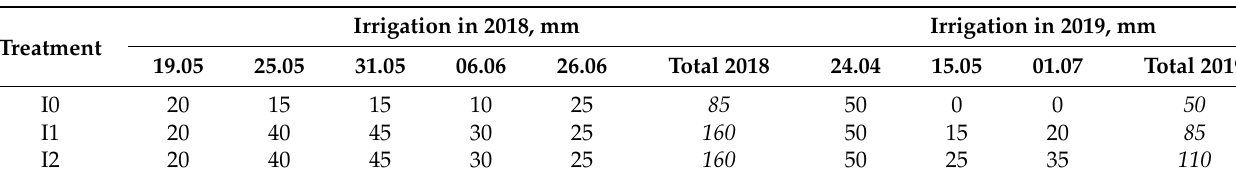
Table A2. Total irrigation amounts for different treatments. I0 corresponds to minimum irrigation, I1 is optimum irrigation and I2 is full irrigation. N0 has no additional fertilization, and N1 has additional N fertilization.